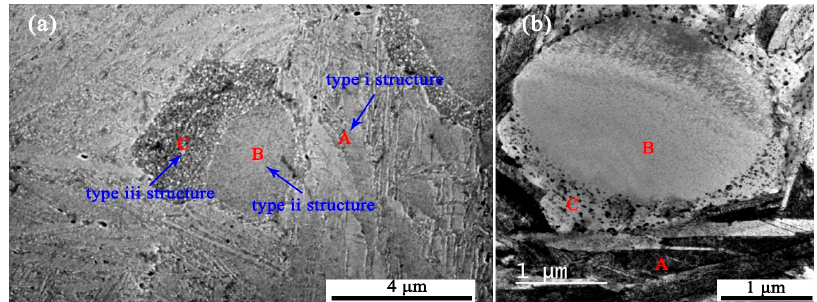
Figure 1. ( a ) SEM and ( b ) TEM bright field maps showing the three types of microstructure of the as-received material.